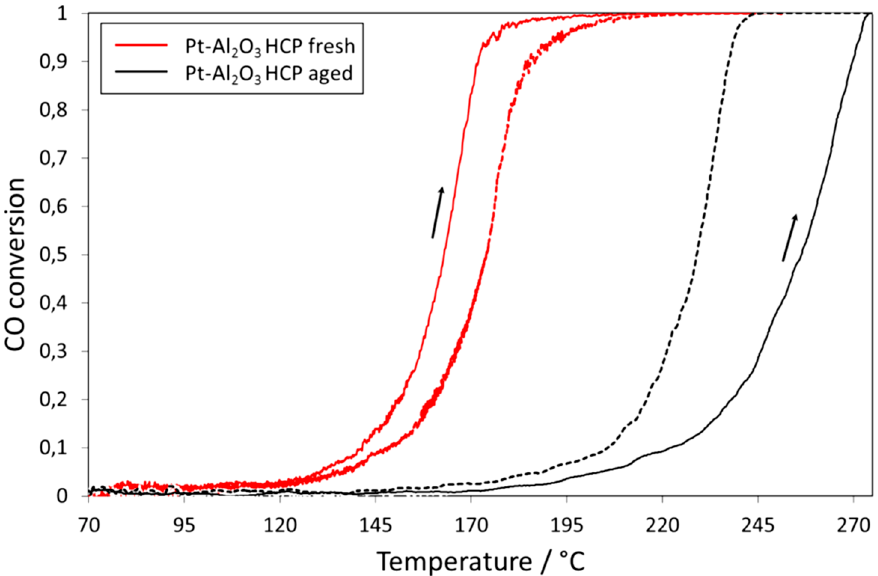
Figure 7. CO oxidation light-off (solid lines, indicated by the arrows) and light-out (dotted lines) over the Pt/Al 2 O 3 catalyst before and after hydrothermal aging [94].